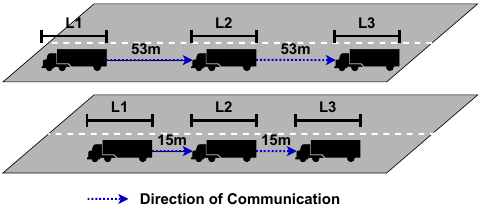
Figure 3. Platoon inter-vehicle space compared to non-platooning